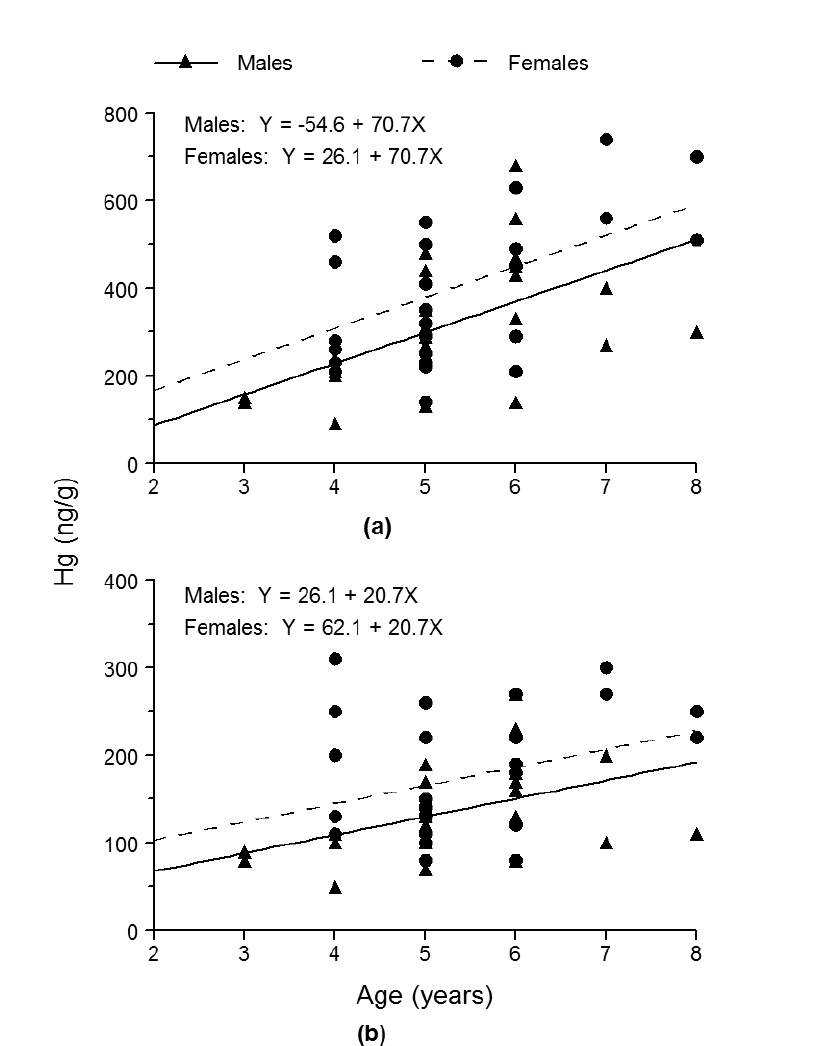
Figure 3. ( a ) Skin-off fillet Hg concentration as a function of age for adult bluegills caught in Squaw Lake (Oakland County, MI, USA) during May 2013. Fitted regression lines from the ANCOVA application to the Hg concentrations are also displayed. ( b ) Whole-fish Hg concentration as a function of age for adult bluegills caught in Squaw Lake (Oakland County, MI, USA) during May 2013. Fitted regression lines from the ANCOVA application to the Hg concentrations are also